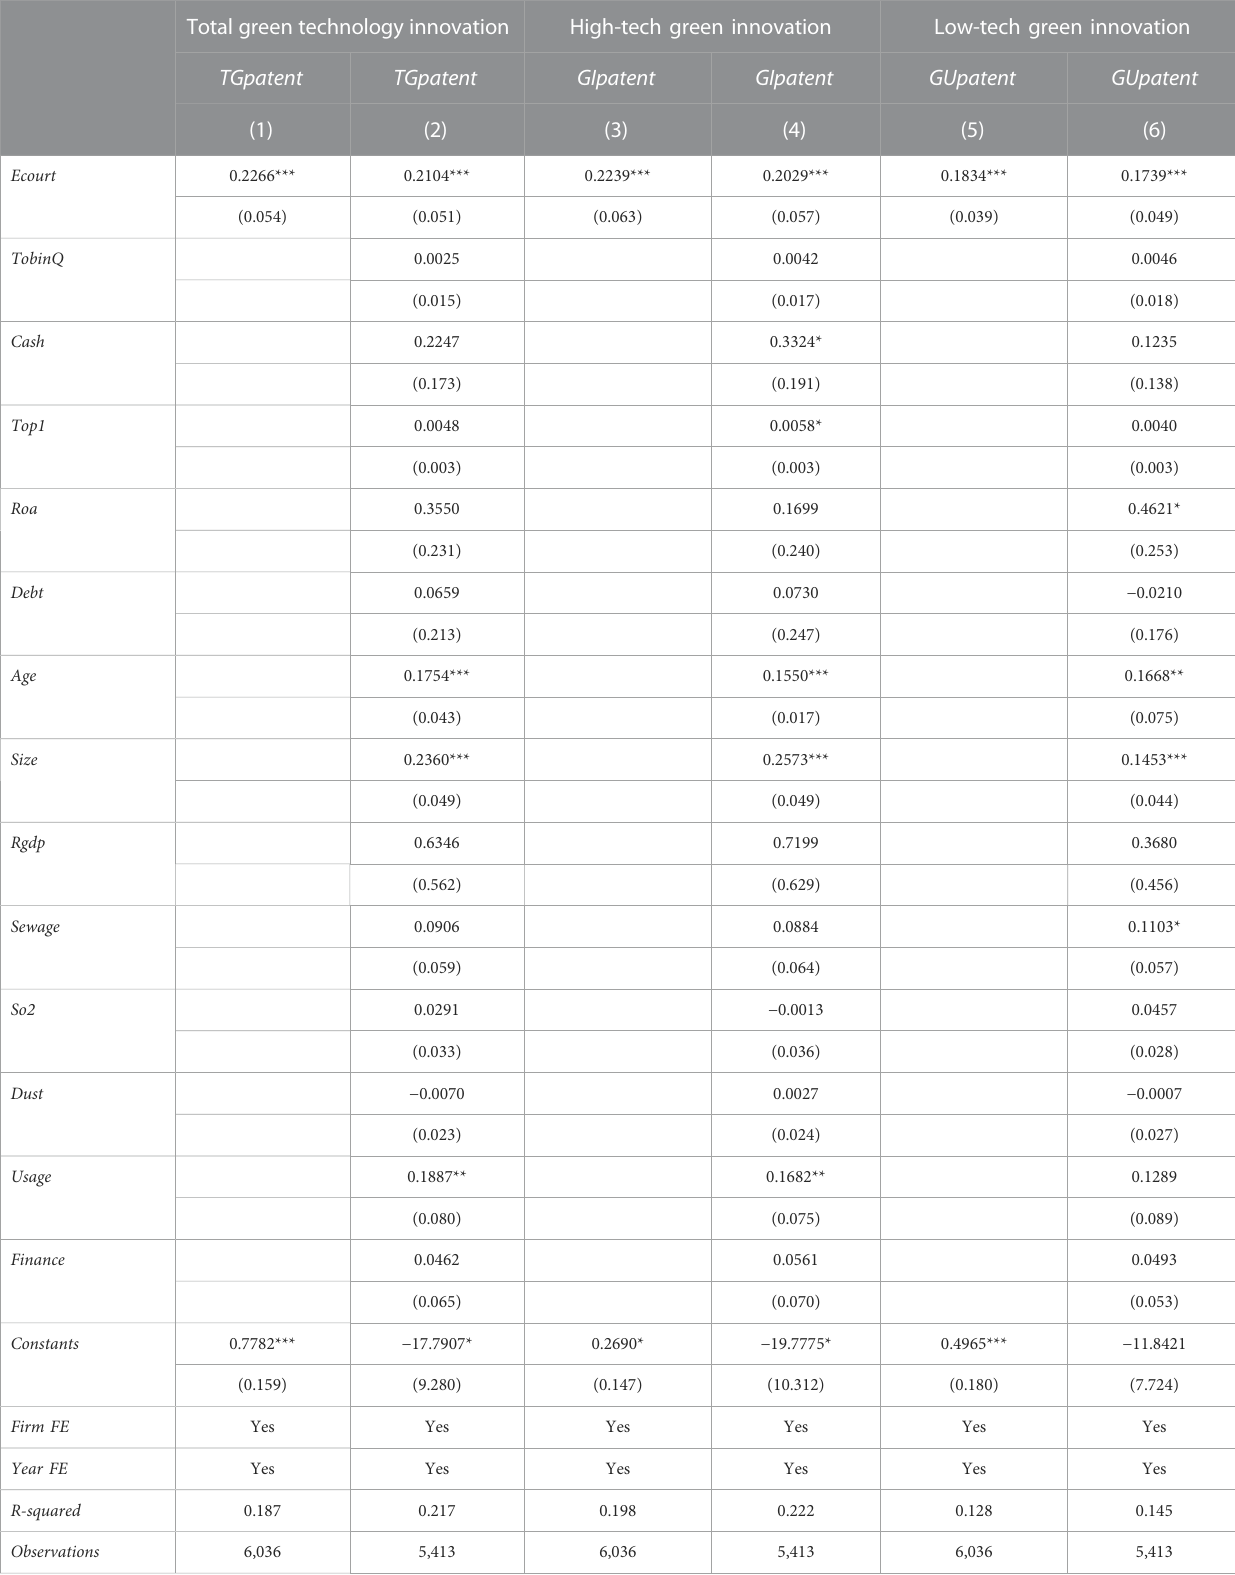
TABLE 2 Baseline